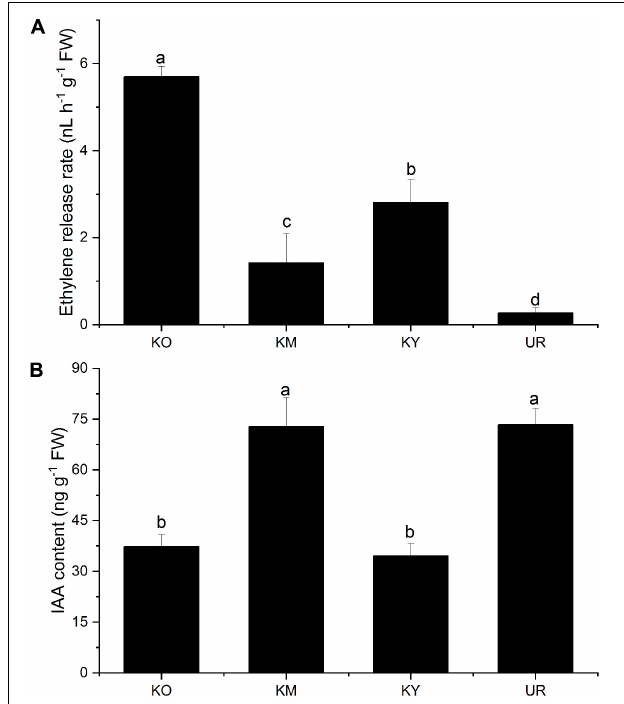
FIGURE 6 | Ethylene release rate (A) and IAA content (B) from different root types of Taxodium ascendens. Values followed by the same letter(s) are not significantly different at P < 0.05, according to Duncan’s multiple range tests. Error bars are SD of the mean; n =